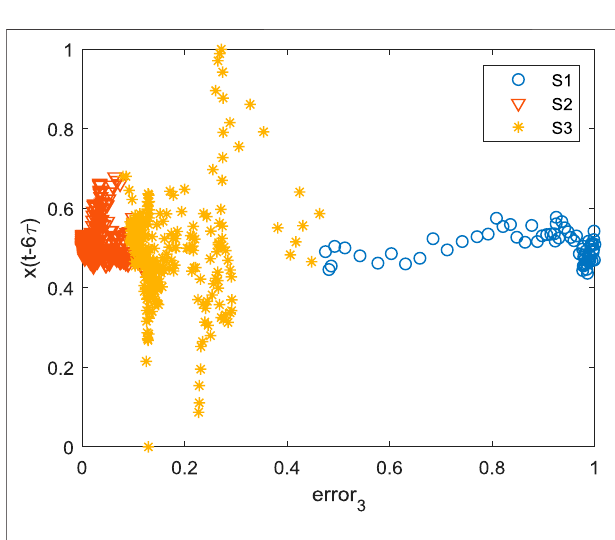
FIGURE 2 | Division of wind